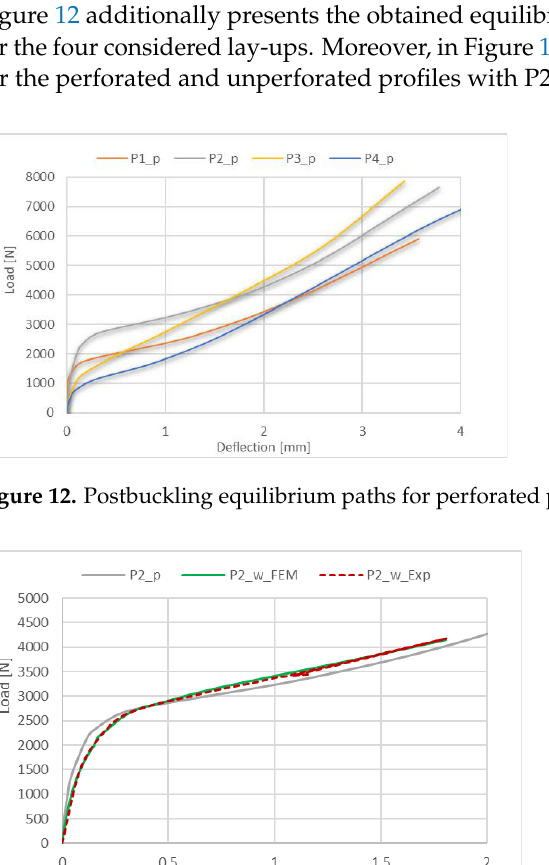
Figure 11. Tsai – Wu critical parameter map with the obtained form of loss of stability for the P2 configuration for: ( a ) unperforated, ( b ) perforated profile.